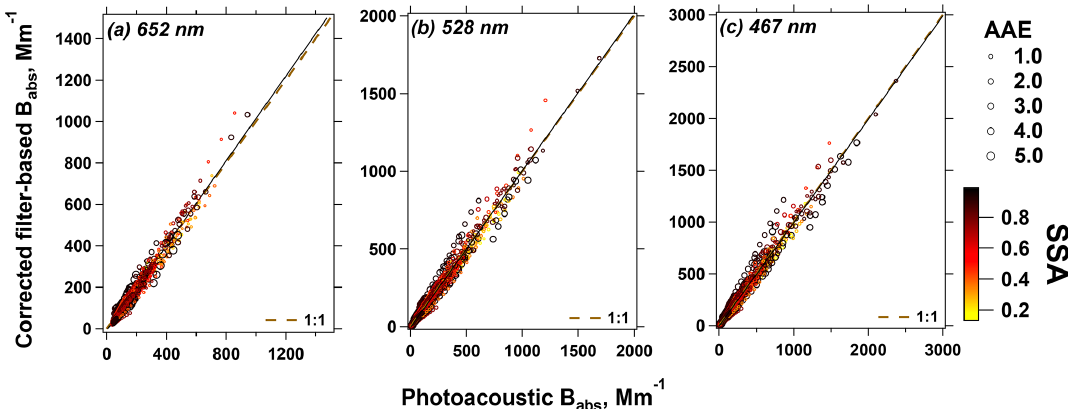
Figure 4. As in Fig. 3, but the CLAP-based B ATN values have been corrected using our Algorithm A.